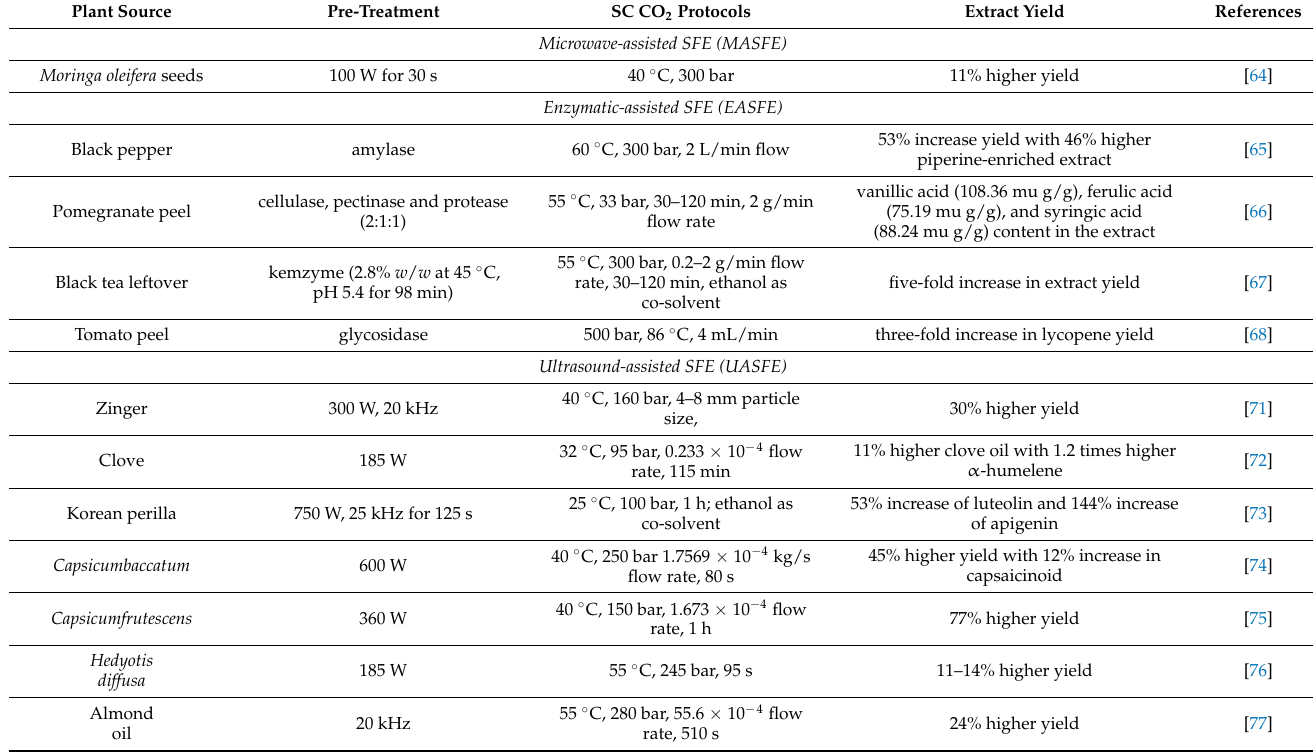
Table 3. Application of various extraction processes as